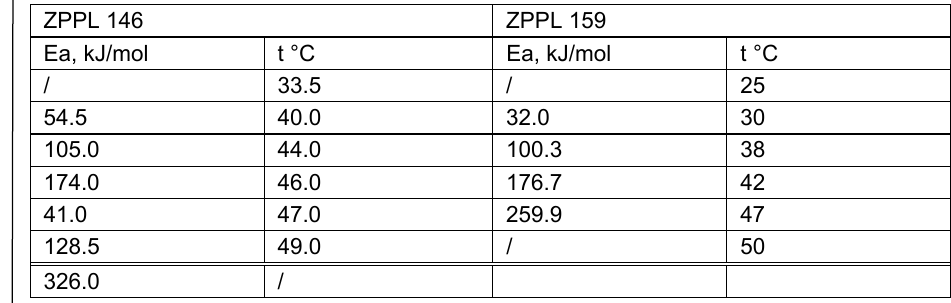
Table 3 – Changes in activation energies (Ea) and critical temperatures (t °C) during the thermal processes in chloroplasts and the thylakoid membrane of the intact above-ear leaf of air dried maize inbred